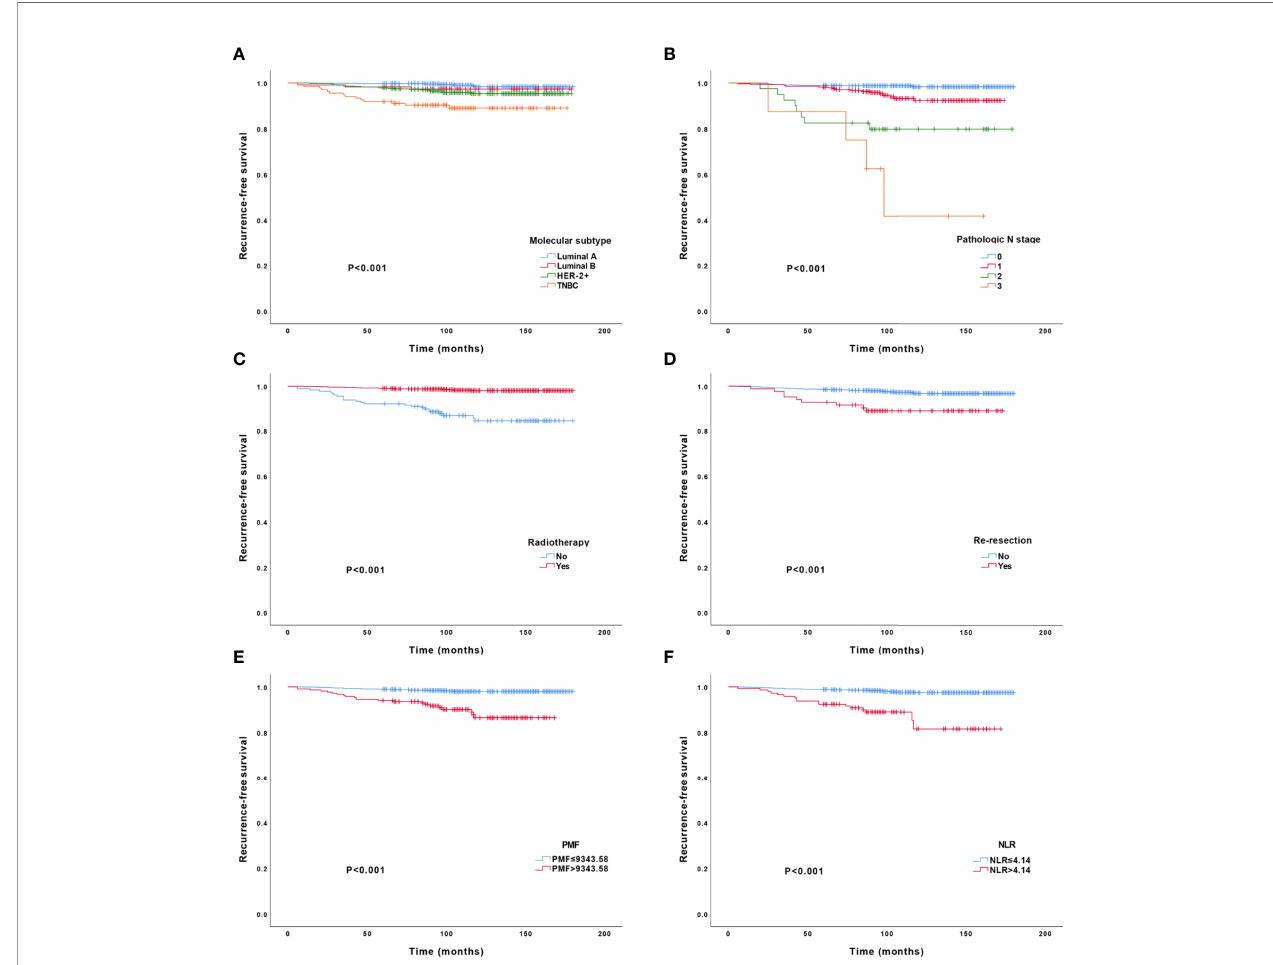
FIGURE 3 | Kaplan – Meier curves for local-regional recurrence. Kaplan – Meier curves for local – regional recurrence based on molecular subtype (A) , pathological N stage (B) , radiotherapy (C) , re-resection (D) , PMF (E) , and NLR (F) . TNBC, triple-negative breast cancer; PMF, platelet count*mean platelet volume* fi brinogen; NLR, neutrophil count-to-lymphocyte count